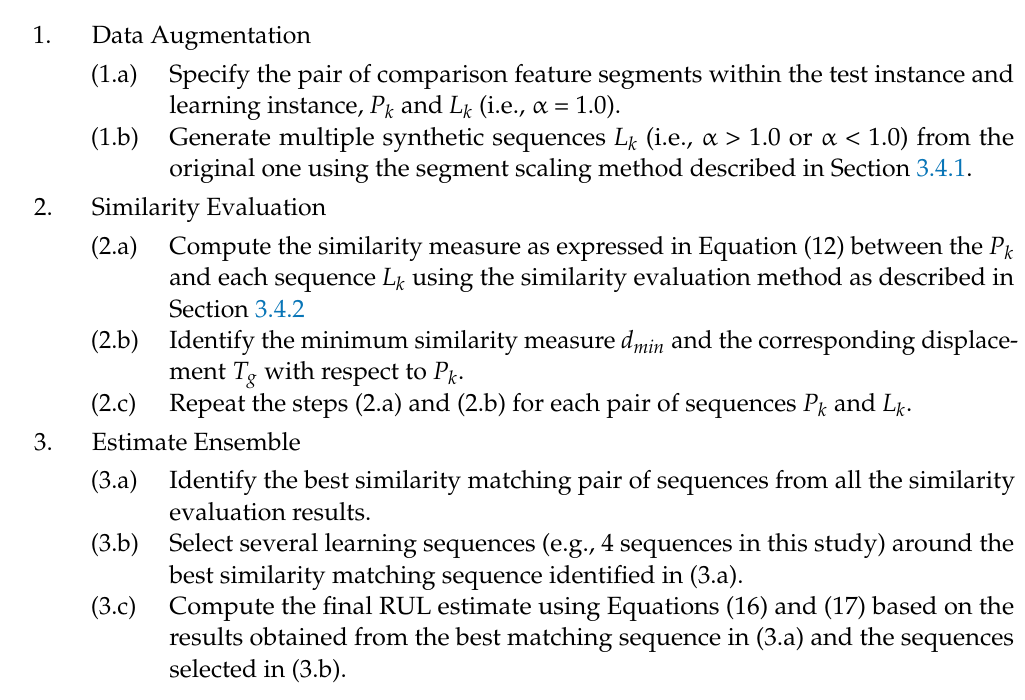
Figure 9. The mean and the first five PCs of the spectrogram of learning instance Bearing1-2. Note: the horizontal axis’ ticks represent 10 Hz per tick mark. Applying the proposed IBL approach to the bearing datasets, we compare the five PC feature sequences between each pair of a test instance and the augmented feature se- quences of the learning instance. The best similarity matching sequence pair can be iden- tified from the test instance vs. each learning instance. It should be noted that we only present the best matching sequence pair and the corresponding RUL estimate results for each test instance here. As a result, the 2nd PC feature sequences were chosen for test instances Bearing1-5, 1-6, and 1-7 paired with the learning instance Bearing1-2. The 1st PC feature sequences are used for Bearing1-4 paired with the learning instance Bearing1-2. Figure 10 shows the five PC feature sequences of the test instances Bearings 1-4, 1-5, 1-6, and 1-7, which are generated by projecting their spectrograms on the PCs of learning instance Bearing1-2.